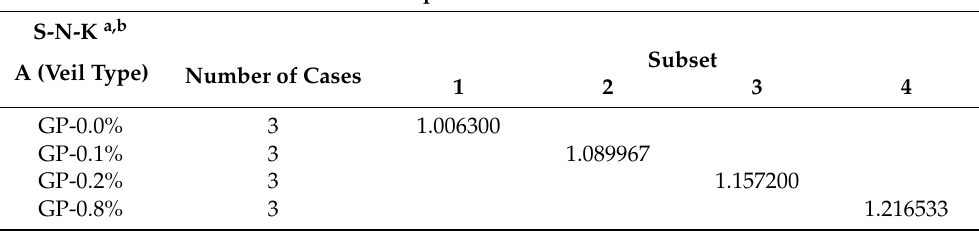
Table 6. Comparison of different types of veils on promoting multiple blood flow on skin microcircu- lation.